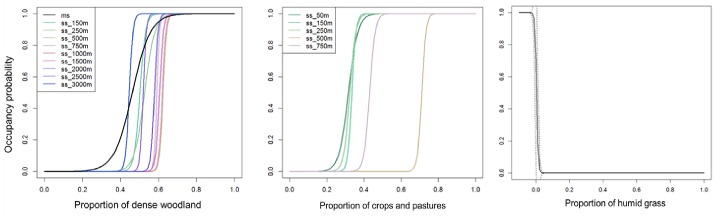
Predicted occupancy probabilities in the periphery as function of the proportion of dense woodland and crops and pastures across single scales.Probability curves plotted for each single scale (ss) correspond to the best model among the models in which the variable appears. Humid_grass curve correspond to the best MS model in which this variable was present.